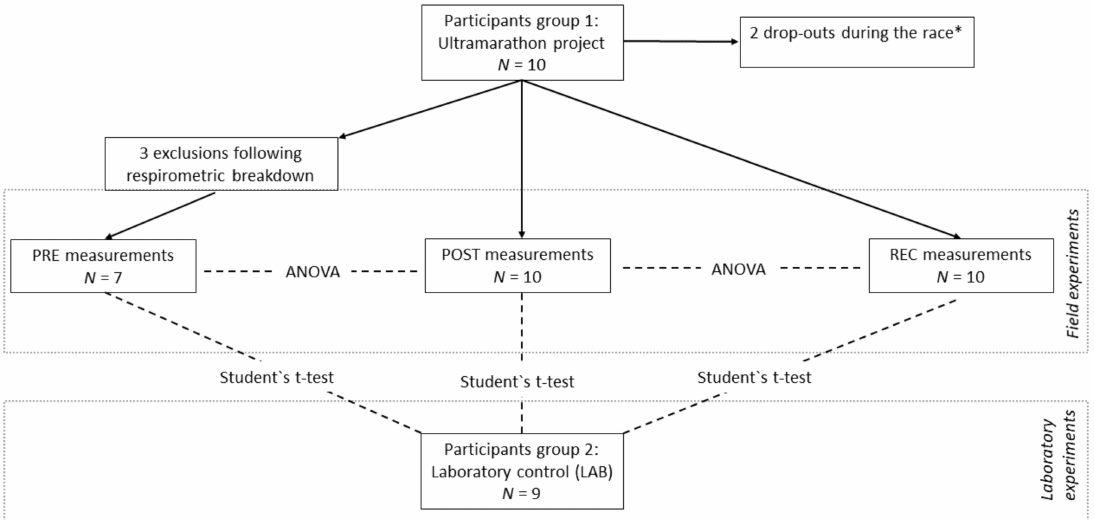
Figure 3. Study design and statistical approach. PRE, prerace measurements; POST, postrace measurements; REC, recovery measurements 24 h after individual finish; LAB, experiments performed in the laboratory of Oroboros Instruments. Repeated measures ANOVA with Bonferroni post-hoc tests was used for PRE-POST-REC comparison, highlighting the impact of systemic stress on experimental quality. Student’s t-test was used to compare LAB-PRE, LAB-POST, and LAB-REC, highlighting the impact of changed environmental conditions on experimental quality. | ∆ ab | of all volume-specific fluxes ( J O 2 ) and FCR were used as parameters. * Experimental data from drop-outs are excluded in the evaluation of biological adaptations, but are included in the present statistics for experimental quality